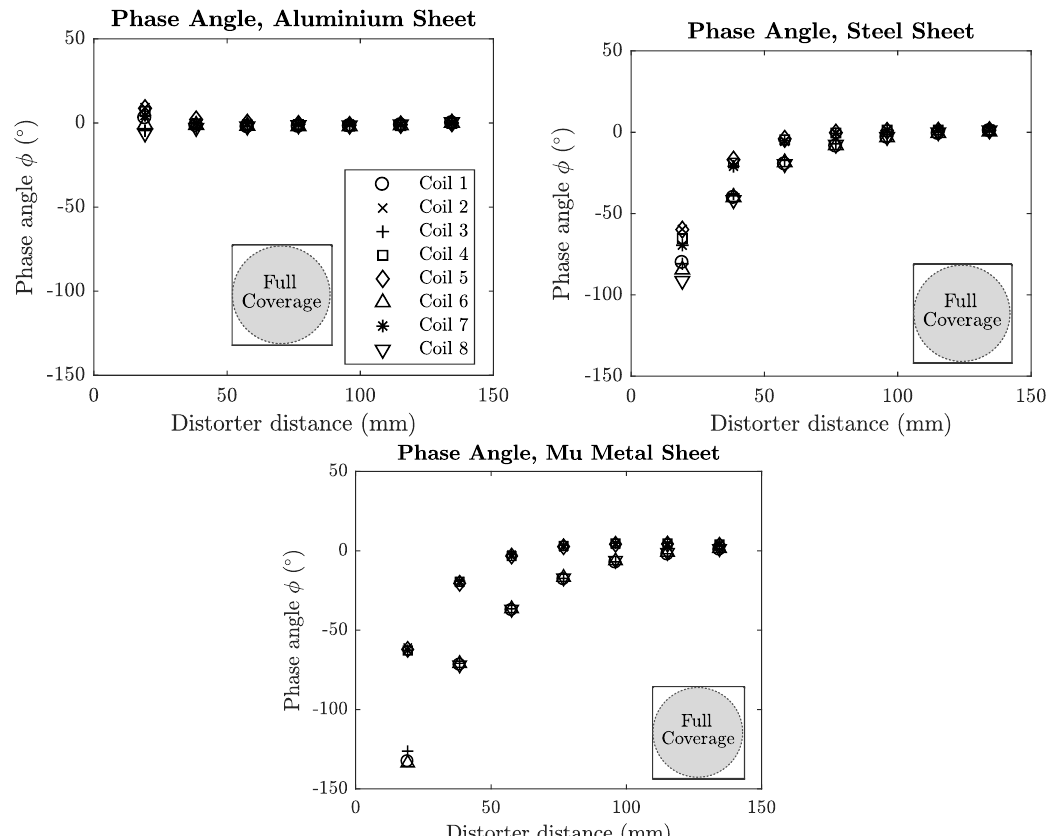
Figure A6. Phase error for planar sheet distorters. The aluminium sheet causes a small positive phase error of approximately 10 ◦ when placed very close to the transmitter, but quickly returns to zero with increasing distance. The steel sheet initially causes very large negative phase errors when close to the transmitter but return to zero at approximately 120 mm from the transmitter. The mu-metal sheet phase error is an exaggerated version of that of the steel sheet, with maximum errors of approximately 140 ◦ .